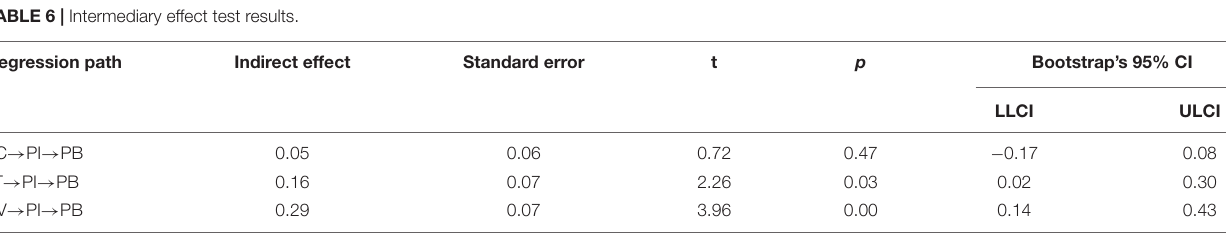
FIGURE 2 | Structural model. “*” means P < 0.05, “**” means P < 0.01, “***” means P < 0.001, “ns” means P > 0.05. TABLE 6 | Intermediary effect test